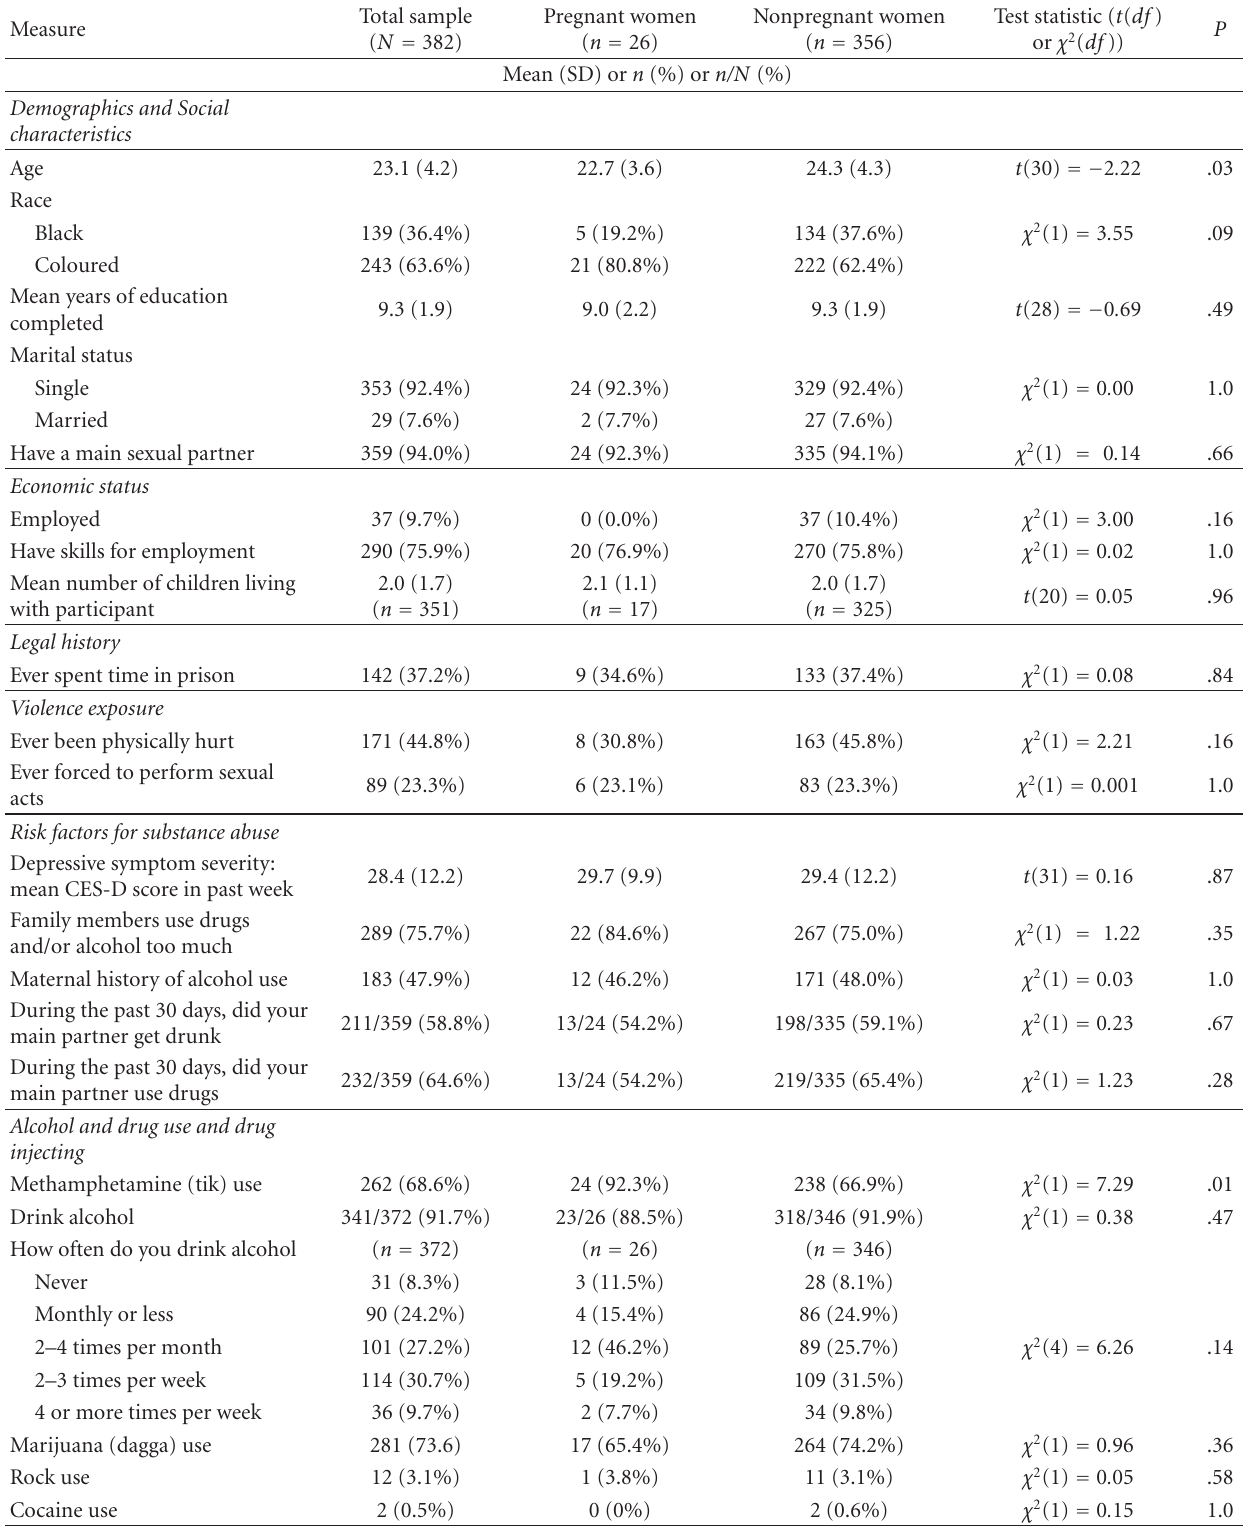
Table 1: Demographic and Background Characteristics of Pregnant and Nonpregnant Women ( N =